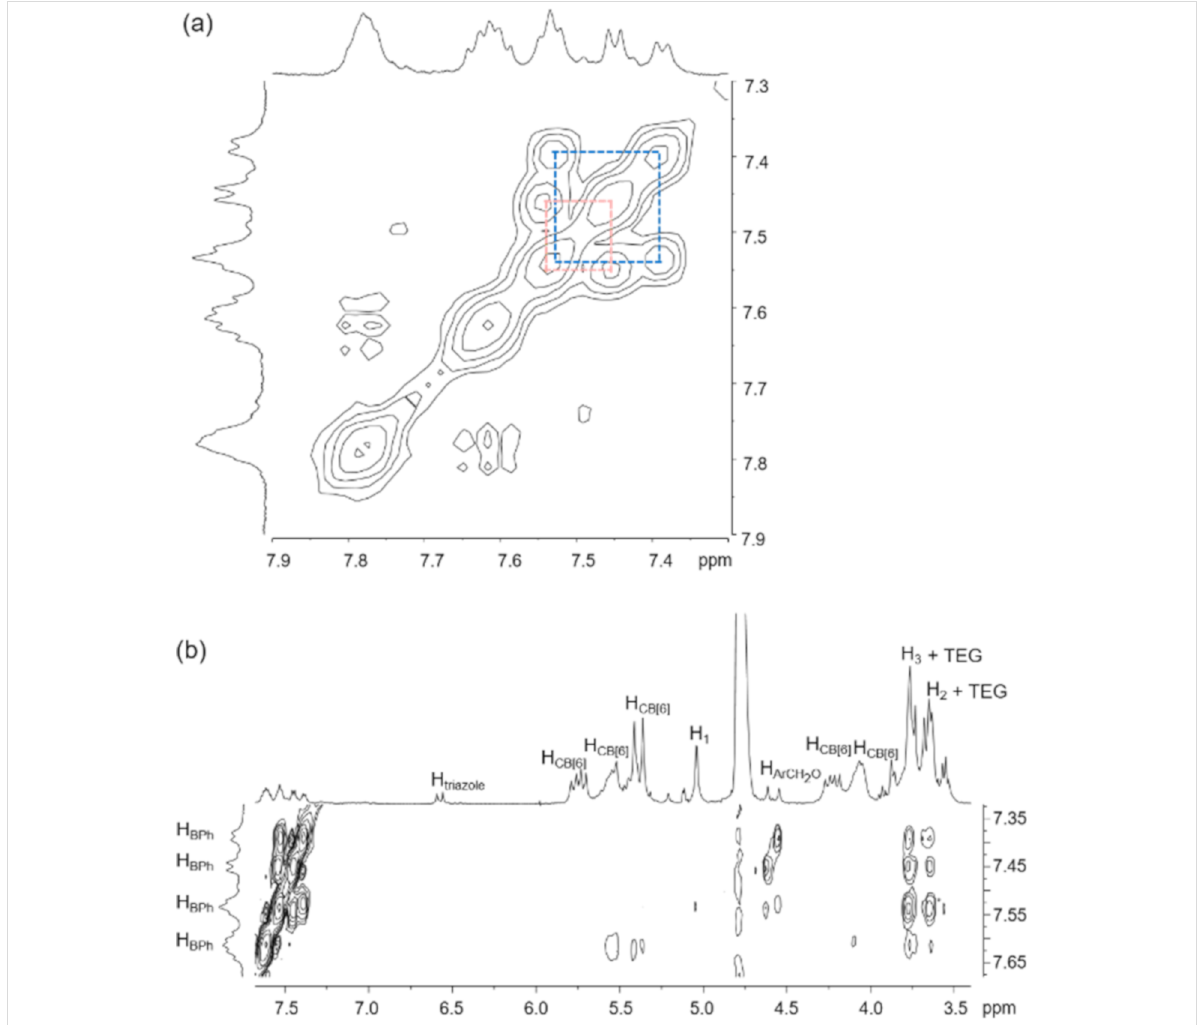
Figure 4: Partial (a) COSY spectrum (500 MHz, D 2 O, 298 K) and (b) NOESY (500 MHz, D 2 O, 298 K) of 4R showing the H BPh protons respectively as two paired of coupled signals and their NOE cross peaks with the H 2 and H 3 protons.